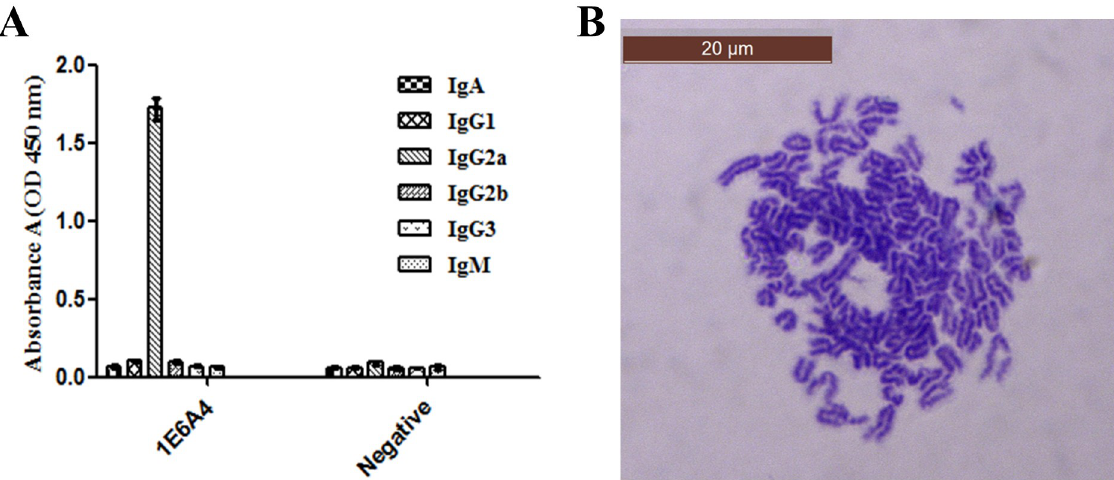
Fig 2. Characterization of positive hybridoma clone. (A) The isotype result of monoclonal antibody from 1E6A4 hybridoma cells. The experiment of antibody isotyping was conducted with isotyping kit, and the isotype of 1E6A4 is IgG2a. (B) Chromosome analysis of 1E6A4 hybridoma cell (10 × 100). The chromosome analysis of 1E6A4 cell line is 102 ± 6.